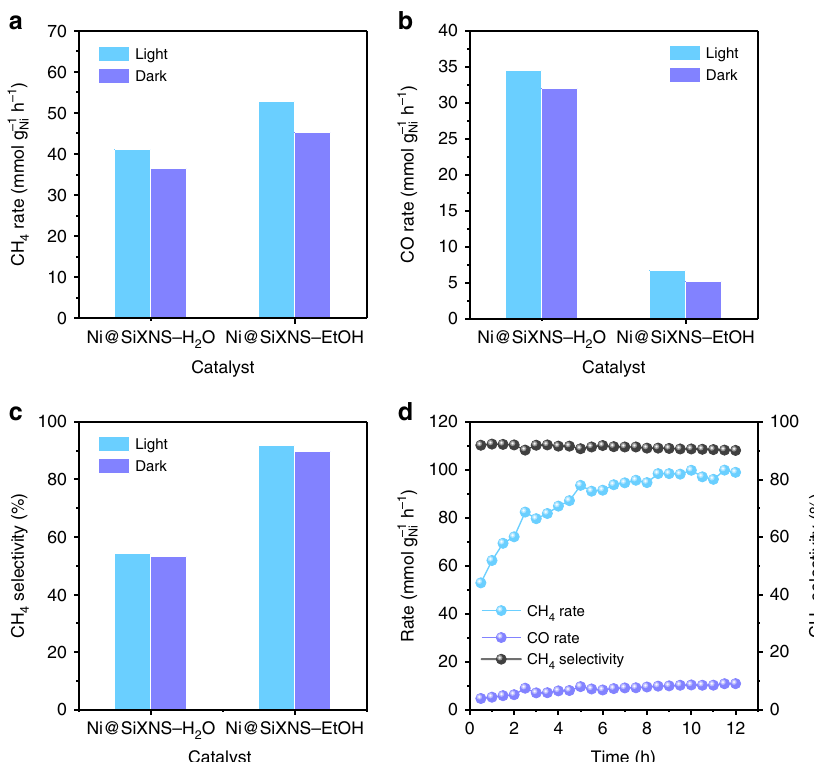
Fig. 5 Catalytic performance of CO 2 methanation on Ni@SiXNS. a , b Observed catalytic rates for a CH 4 production and b CO production by Ni@SiXNS samples under light and dark conditions. c CH 4 selectivity of Ni@SiXNS samples for CO 2 methanation under light and dark conditions. d CH 4 production rate and selectivity as well as CO production rate of Ni@SiXNS-EtOH for CO 2 methanation under illumination for a continuous 12 h at atmospheric